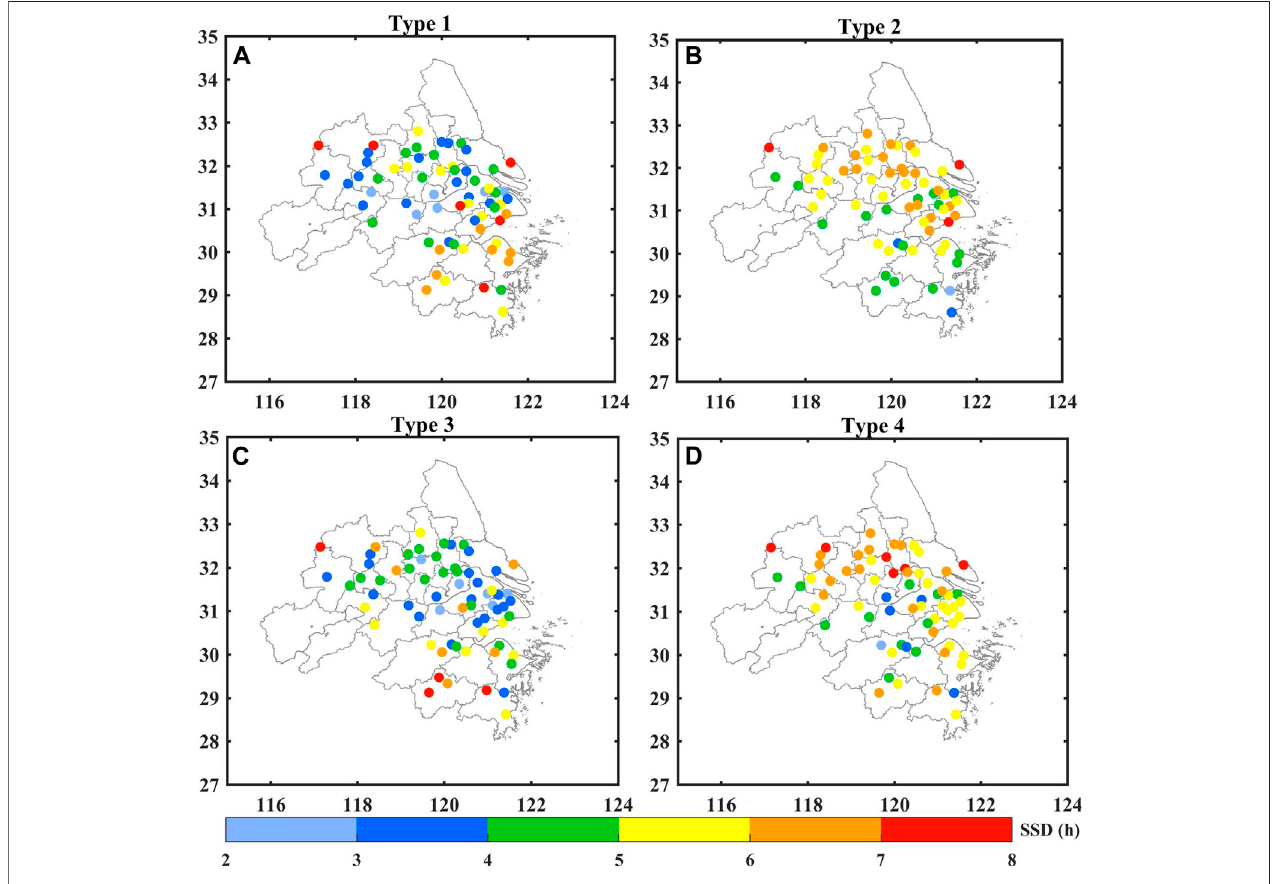
FIGURE 12 | As in Figure 9 but for mean Sunshine Duration